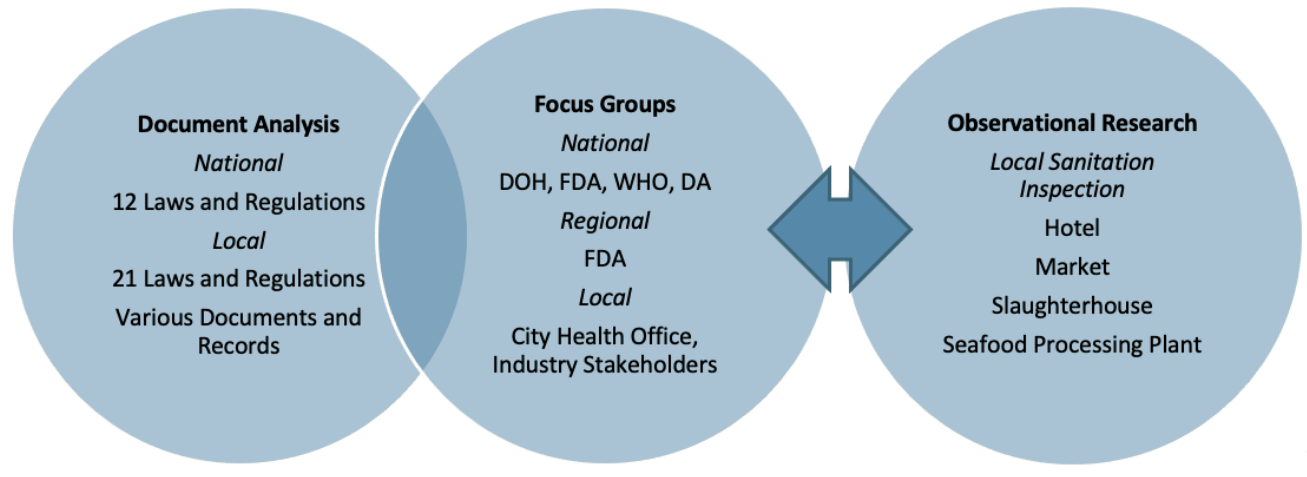
Figure 1. Techniques and samples lending to correlational study (documents and focus groups) and to observational re- search.